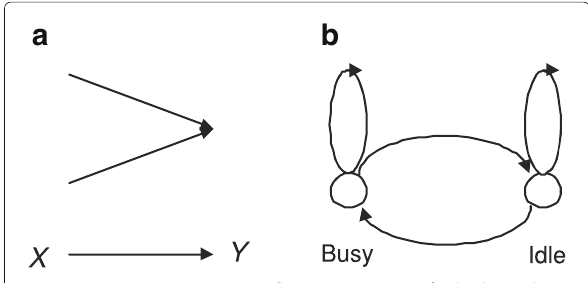
Fig. 2 a Input-output mapping. b State transition of sub-channel